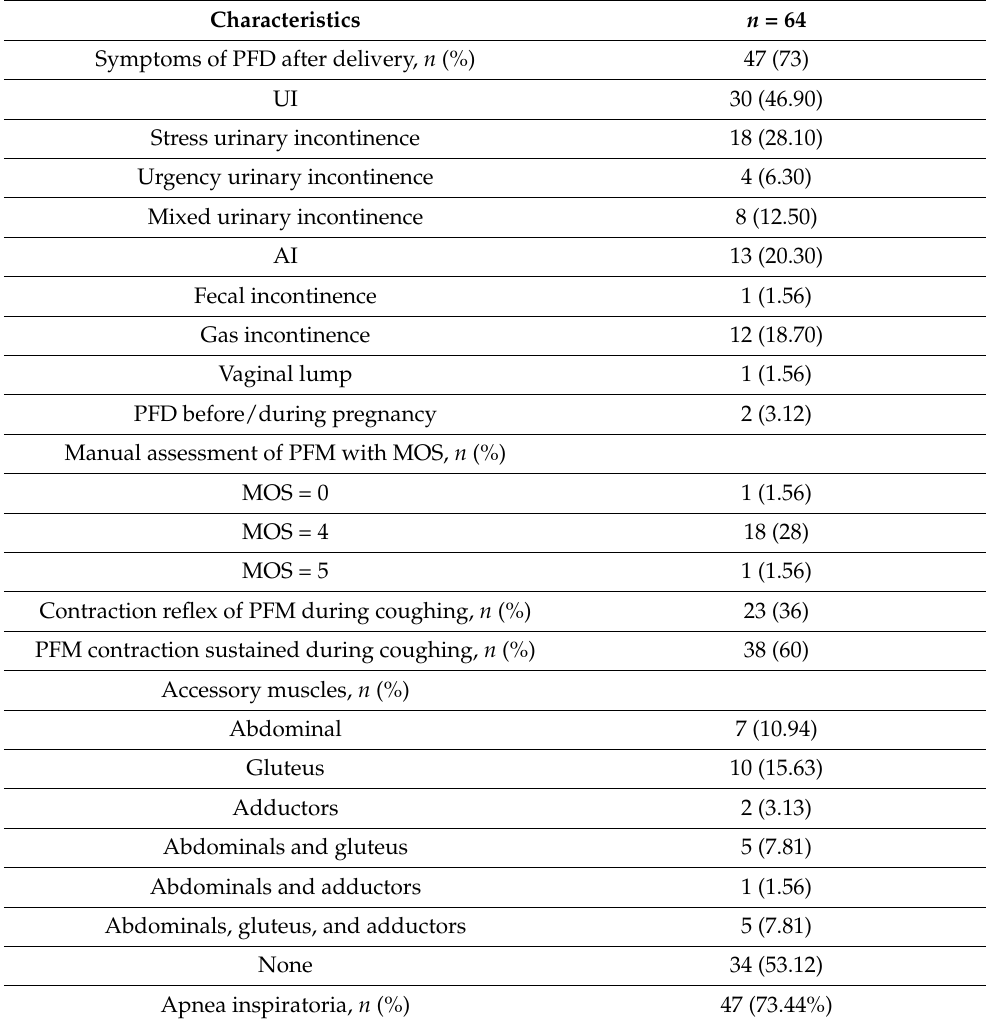
Table 2. Clinical characteristics of participants.